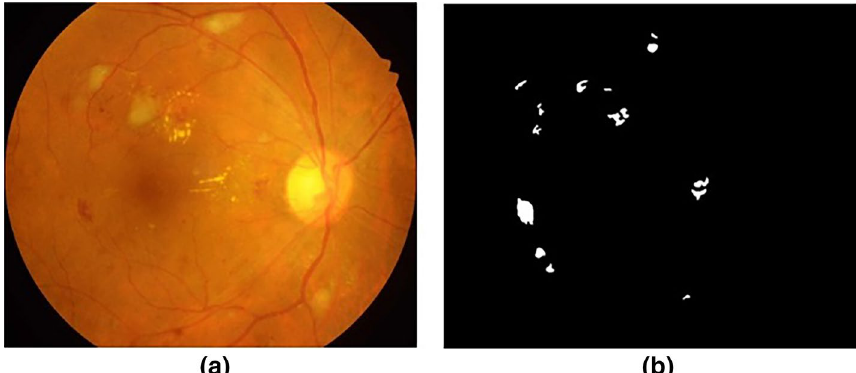
Fig. 8 a Examples of a fundus image with retinal hemorrhages from the IDRiD database and b ground‑truth examples of retinal hemorrhages from the IDRiD database